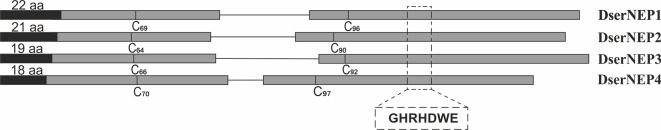
Diagram shows the overall organization of DserNEP genes. The E1–E2 exons are represented in dark gray boxes. Both are separated by an intron (single line). The position (relative to the initial methionine residue) of the two conserved cysteine residues typical of type I NLP proteins is indicated. Signal peptides are indicated by black boxes. The relative location of the central hepta-peptide motif typical of NLP proteins in E2 is indicated (italics).